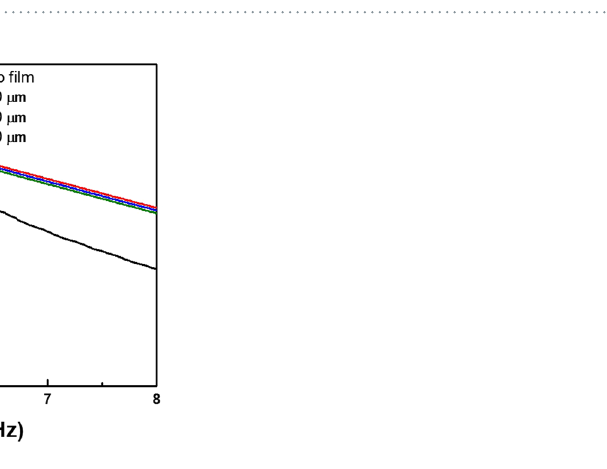
Figure 6. ( a ) Simulated spectra of the transmission for incident angle from 0 to 10 degrees in step of 1 degree for the unbent sample. Power-loss-density distribution ( b ) at 5.69 GHz (I) in the unbent state ( c ) at 5.55 (I) and 5.91 (II) GHz in the bent state (R = 250 mm), and ( d ) at 5.26 (I) and 5.69 (II) GHz in the bent state (R = 180 mm). Surface current distributions corresponding to transmission peak II at incident angle of ( e ) 0 and ( f ) 10 degrees. ( g ) Dispersion plot of the transmission as a function of frequency and incident angle for the CWR-RR structure.